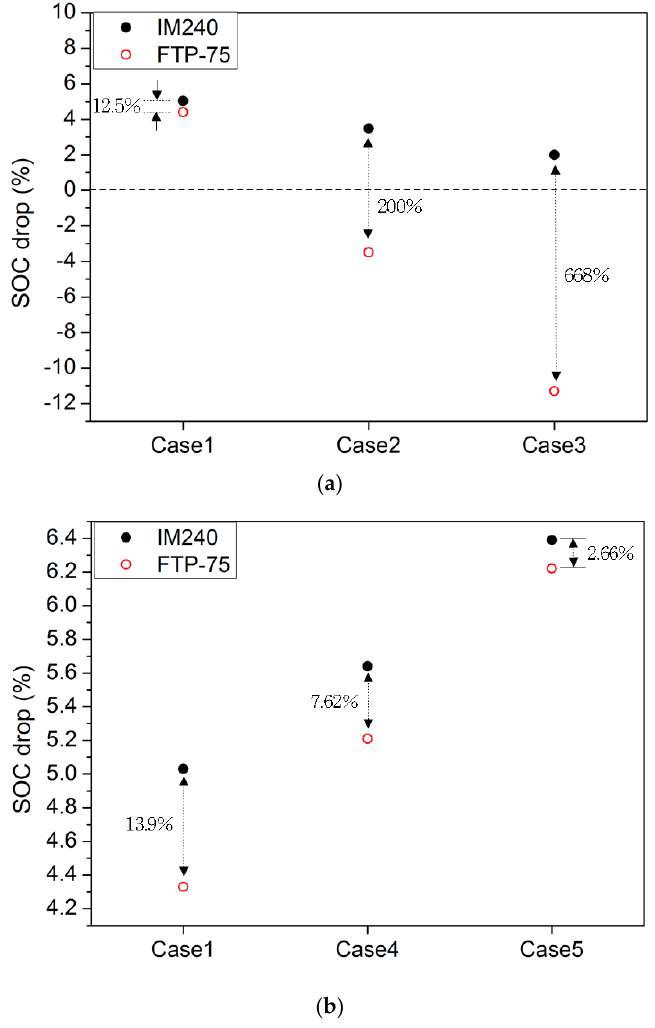
Figure 10. Difference in the SOC drop between IM240 and FTP ‐ 75 modes: ( a ) reduced engine torque; ( b ) reduced battery capacity. ( b ) reduced battery